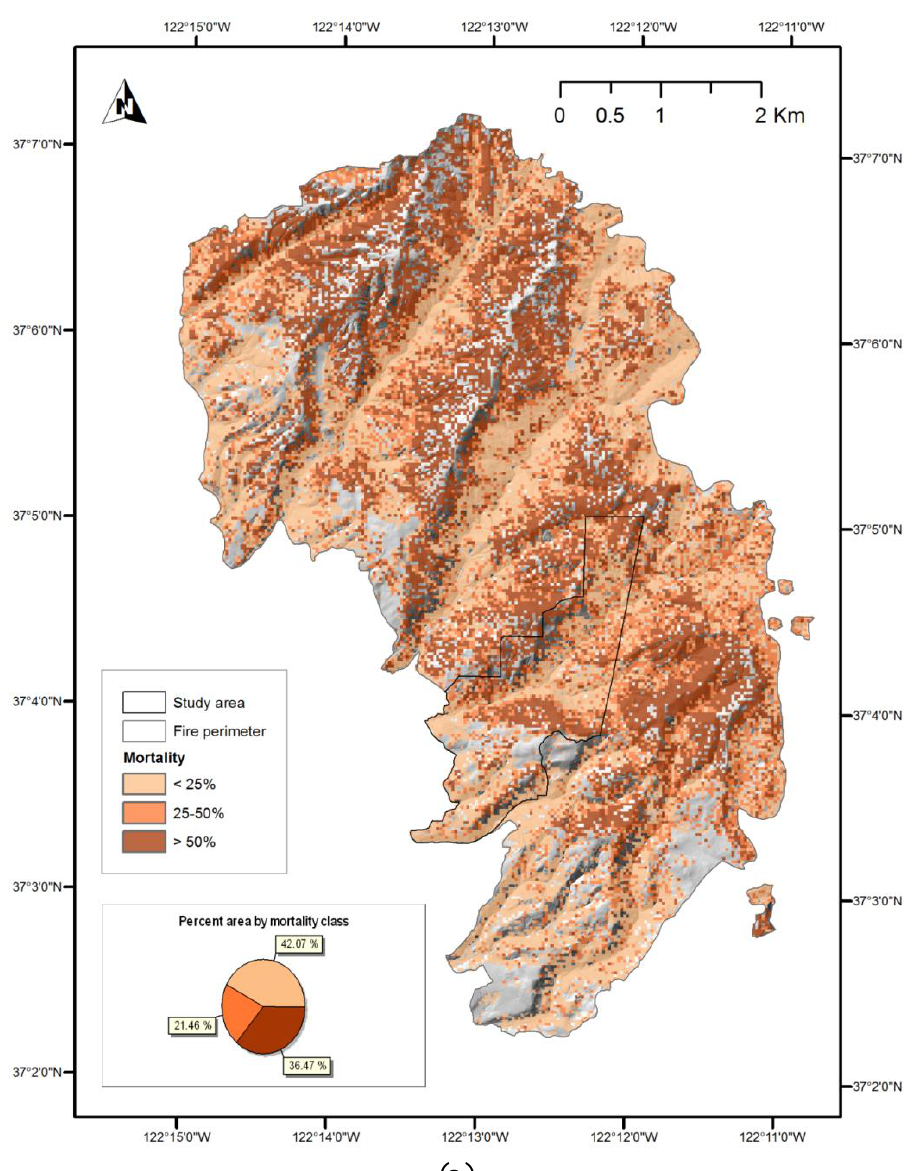
Figure 8. Maps of estimated mortality for the entire fire area using ( a ) Model A—NDVI only; ( b ) Model B—NDVI & post-fire LiDAR; ( c ) Model C—NDVI & differenced